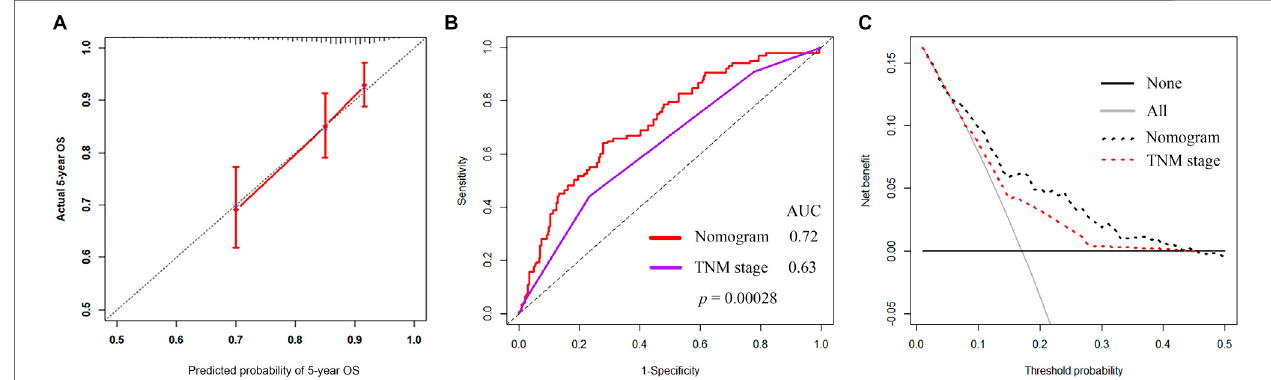
FIGURE 6 | (A) Calibration curve of the model to predict 5-year OS. (B) Time-dependent ROC curves of the model and the TNM stage. (C) DCA of the nomogram and TNM stage for predicting 5-year OS in BC patients.